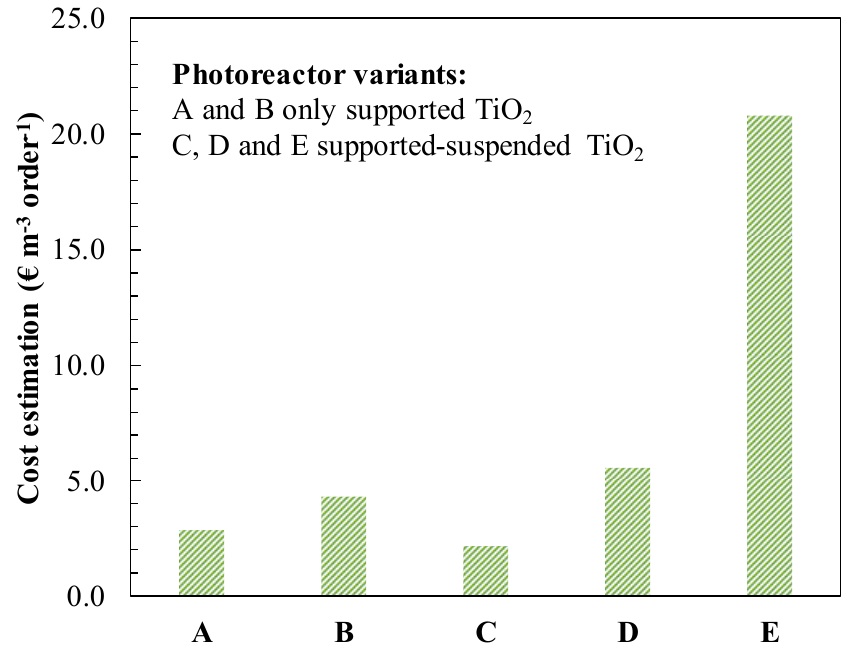
Figure 13. Electrical cost estimation for photocatalytic oxidation of mixtures of aniline and benzothiazole. Photoreactor variants: A and B, only supported TiO 2 (pH = 8.0); C, D and E, supported-suspended TiO 2 at pH = 12. Conditions: A (pH = 8.0), B (pH = 12.0), C ([TiO 2 ] = 60.0 mg L − 1 ), D ([TiO 2 ] = 80.0 mg L − 1 ), E ([TiO 2 ] = 100.0 mg L − 1 ).